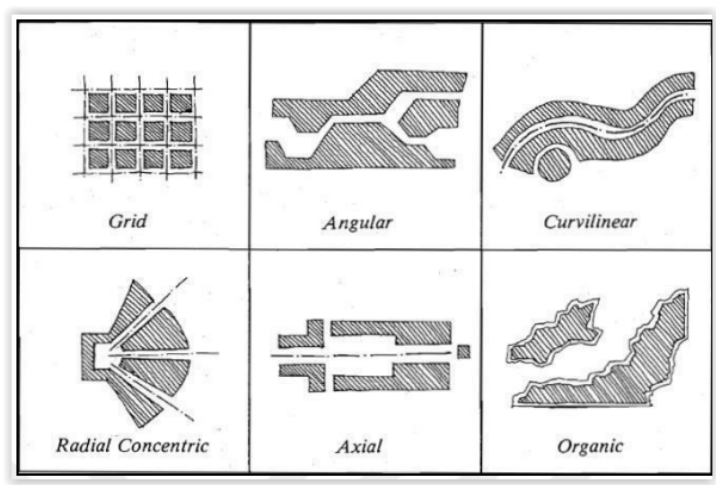
Figure 5 Linkage varieties in different typologies (Trancik, 1986)